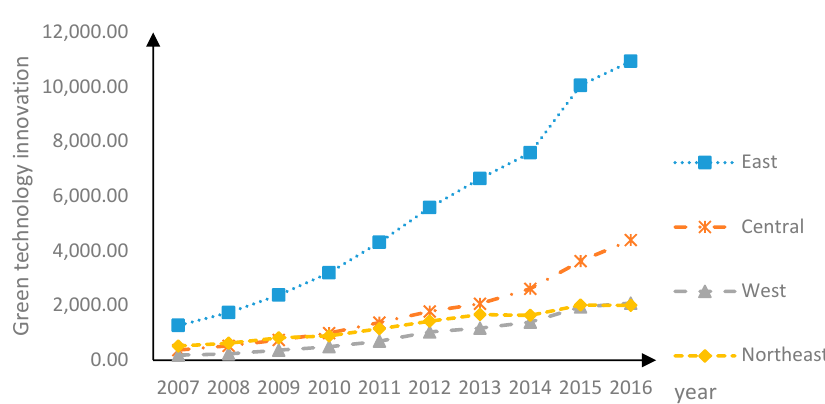
Figure 1. Change trend of GTI level in China in 2007–2016.